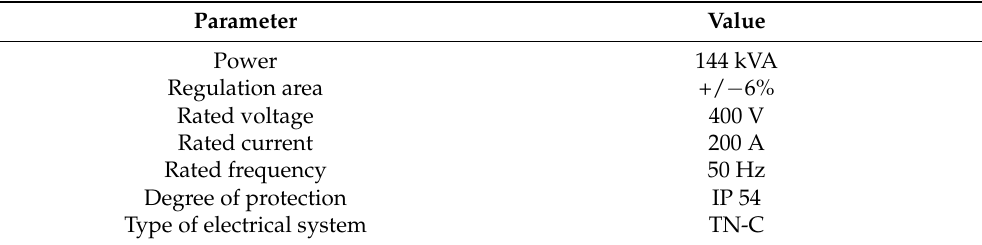
Table 2. Selected parameters of the LVR-sys device; data according to